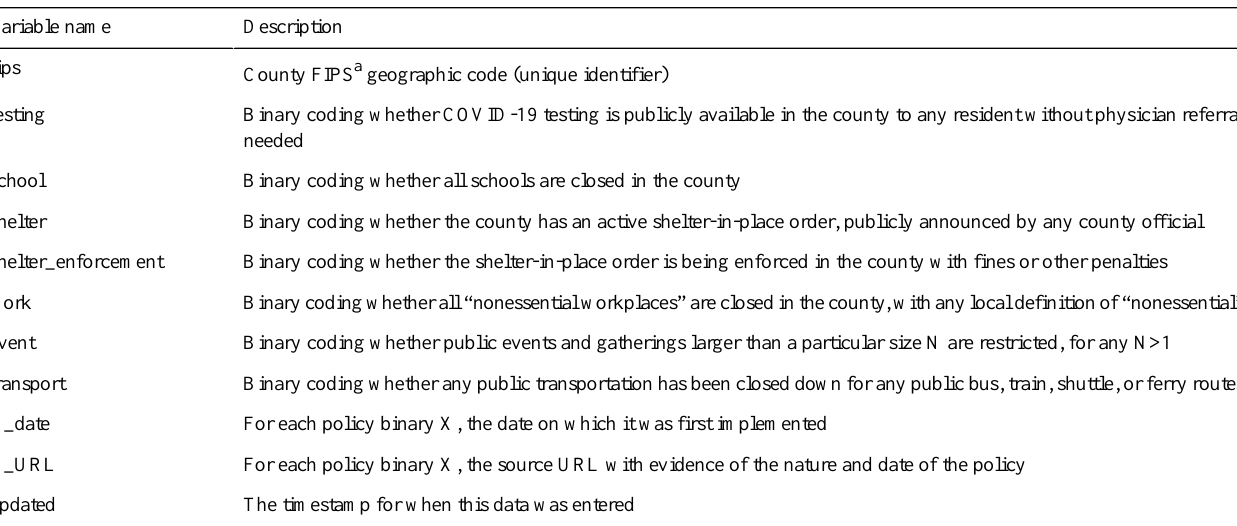
Table 1. Variables in the Hikma Health data set of county-level nonpharmacologic intervention policies. DescriptionVariable